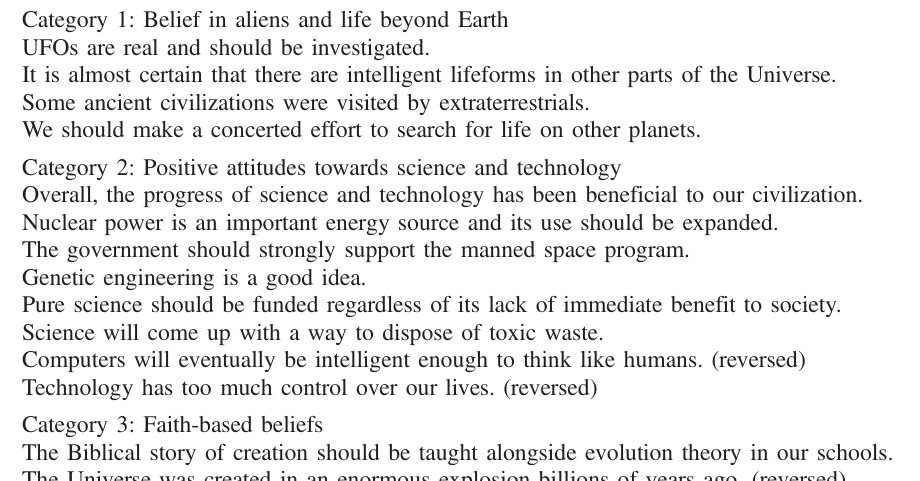
TABLE I. Initial belief and attitude categories resulting from expert